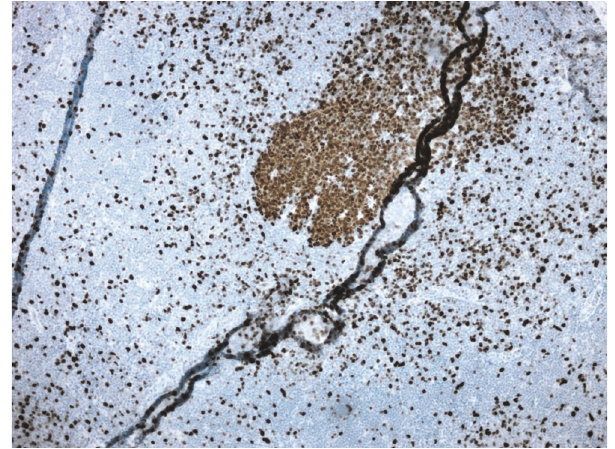
Figure 6: Mantle cell lymphoma involving thyroid (100x). Positive staining with CD43.